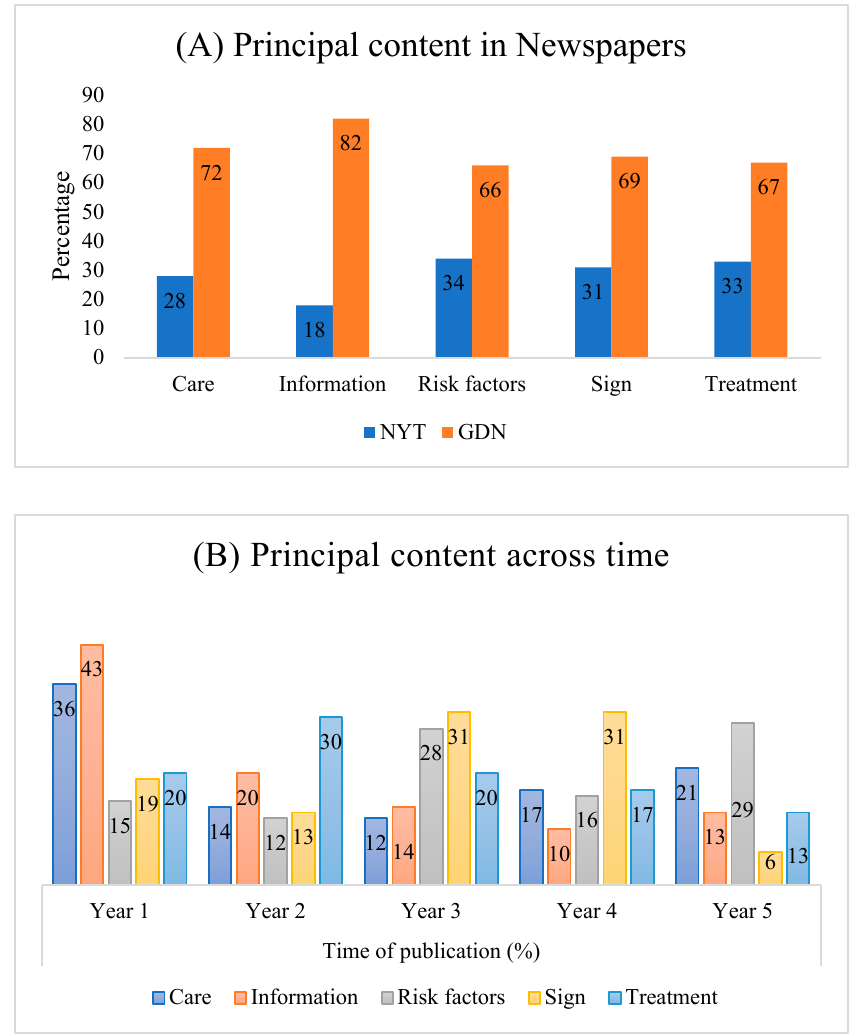
Figure 1. Principal content in NYT and GDN from Year 1 to Year 5. ( A ) Principal content in NYT and GDN, including care, information, risk factors, signs, and treatment. ( B ) Principal content of different categories across time from both NYT and GDN.